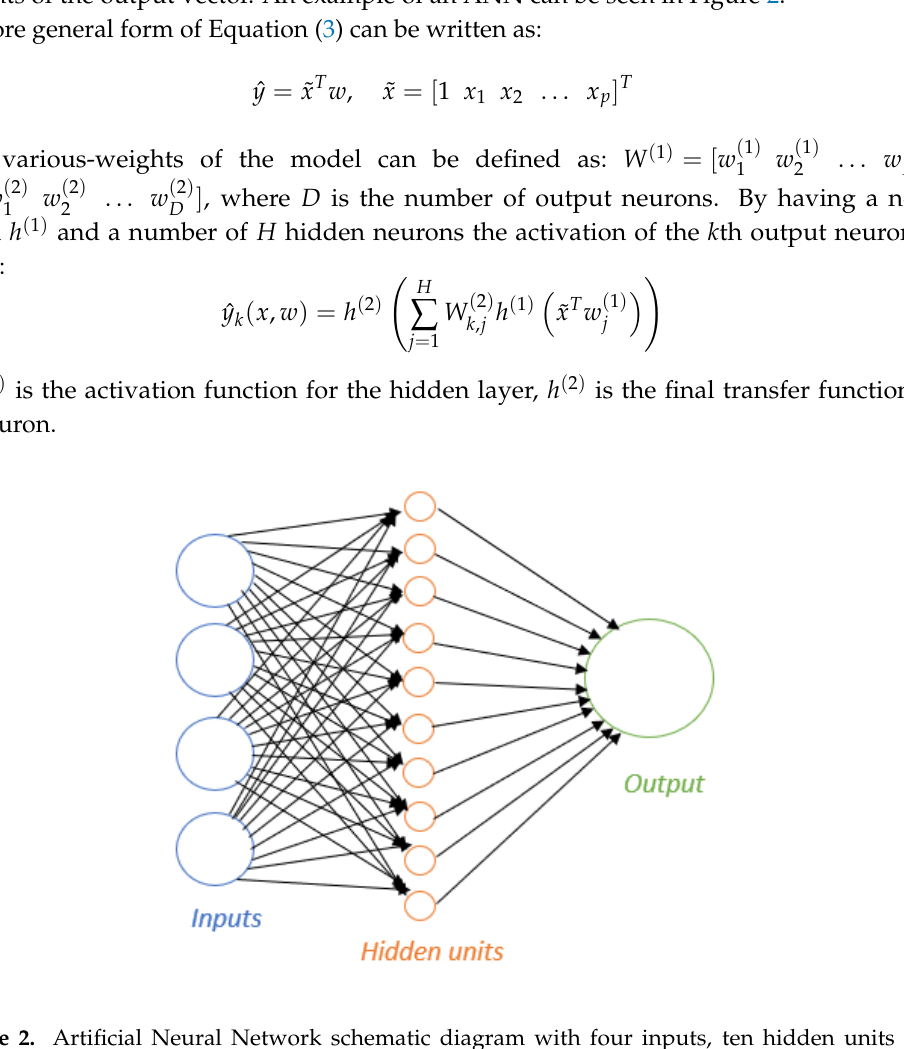
Figure 2. Artificial Neural Network schematic diagram with four inputs, ten hidden units and one